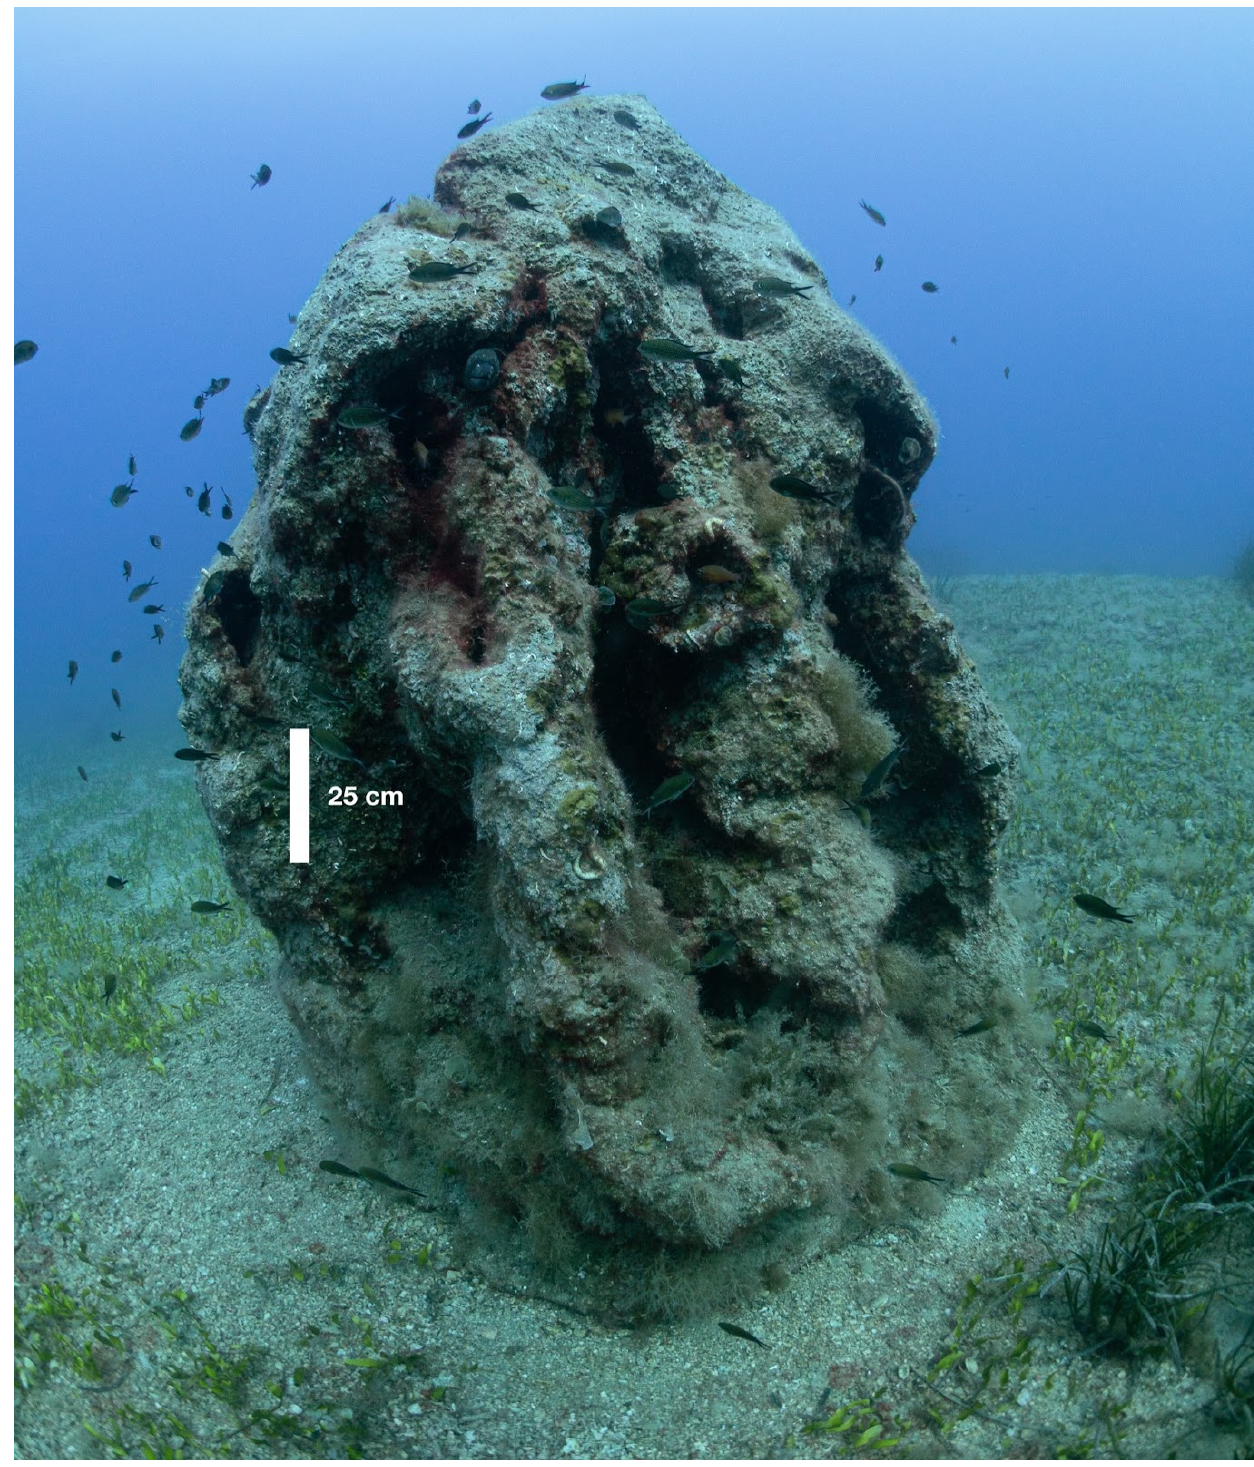
Figure 2. Concrete artificial reef installed at the Underwater Biotechnological Park of Crete (UBPC), photographed 4 years post-deployment (Photo credit: Thanos Dailianis).